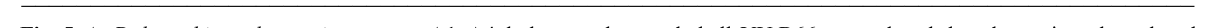
Fig. 5. A , Dolerorthis nadruvensis sp. nov.: A1 – A4 , holotype, damaged shell VU B66, ventral and dorsal exteriors, lateral and posterior views. Sutkai-89 drill core, depth 1191.6 m, Oandu Stage (formations not identified). B , shell GIT 716-366: B1 , ventral exterior; B2 , view of ventral interarea with thickened edges of delthyrium; B3 , B4 , anterior view and dorsal exterior; x on B4 marks the place of B5 , view of the ornamentation with the lamellae. Pajevonys-13 drill core, depth 1190.9–1191.0 m, Šakiai Fm., Oandu Stage. C , ventral valve interior of GIT 716-436-2, Kybartai-29 drill core, depth 1268.8–1268.9 m, Oandu Stage (formations not identified). D , dorsal valve interior, GIT 716-436-1, Kybartai-29 drill core, depth 1268.8–1268.9 m, Oandu Stage. E , view of interior of incomplete ventral valve GIT 716-440, Kybartai-29 drill core, depth 1275.9 m, Oandu Stage. F , interior of incomplete ventral valve GIT 716-226, Pajevonys-13 drill core, depth 1188.9–1189.0 m, Jakšiai Fm., Rakvere Stage(?). G , interior of dorsal valve GIT 716-232. Pajevonys-13 drill core, depth 1192.0–1192.2 m, Šakiai Fm., Oandu Stage. H , incomplete dorsal valve GIT 716-231: H1 , H2 , views of cardinalia, left brachiophore is broken; on the right side the brachiophore is long wing- shaped, the socket and accessory socket occur below the anterior edge of the interarea. Pajevonys-13 drill core, depth 1192.0– 1192.2 m, Šakiai Fm., Oandu Stage.